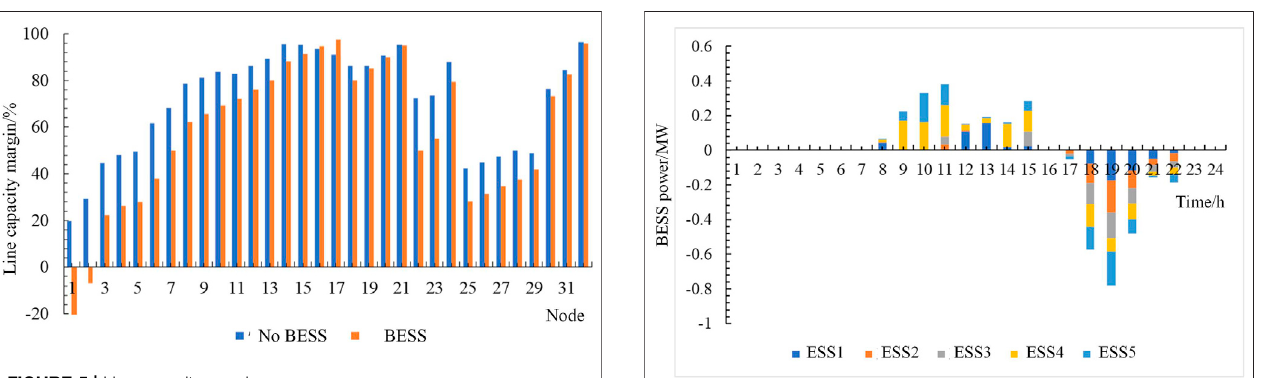
FIGURE 5 | Line capacity margin.